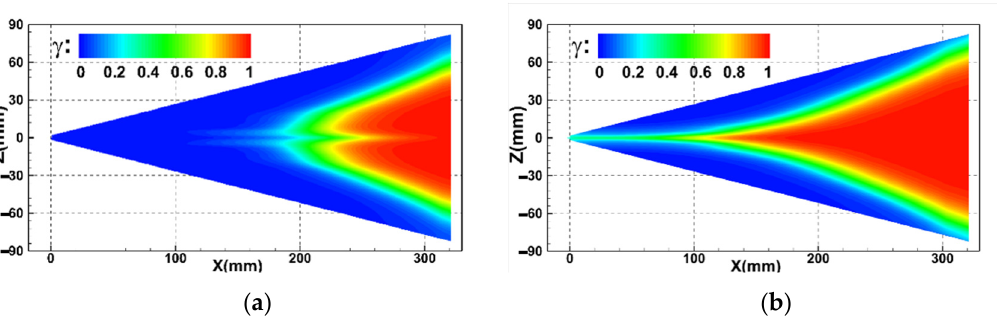
Figure 6. Comparison of γ distributions. ( a ) without aerodisk, ( b ) with 2 mm long aerodisk.